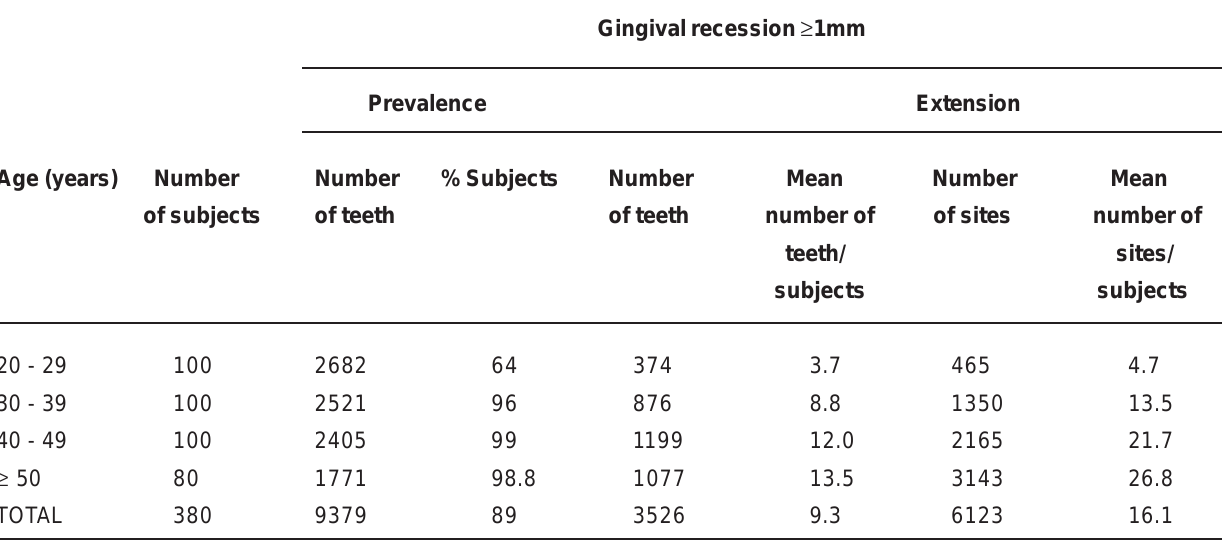
TABLE 1 - Prevalence and extension of gingival recession according to age group